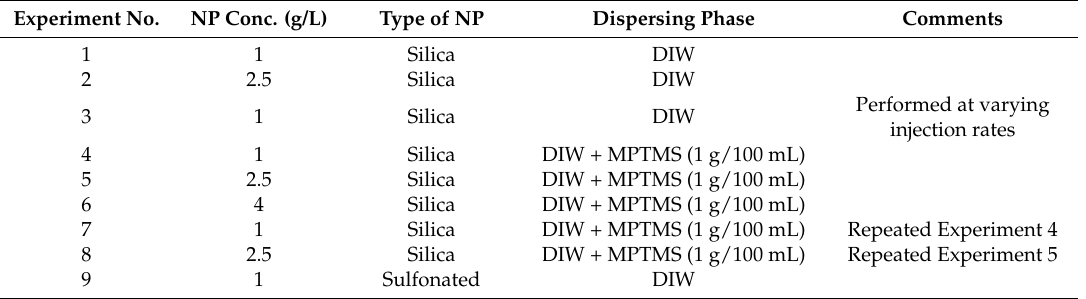
Table 3. List of injection experiments performed in this study. Experiment